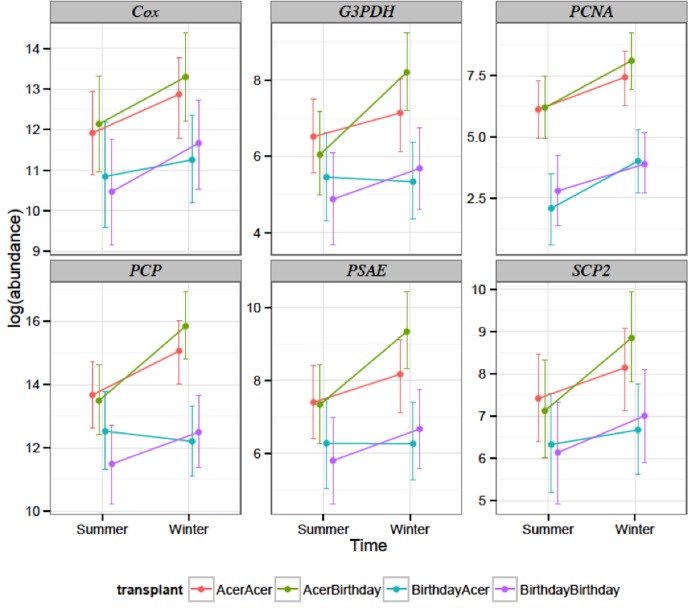
By-gene plot of transcript abundance for zooxanthellae genes obtained from sub-samples of Porites astreoides taken from Birthday reef and Acer24 reef during winter and summer sampling efforts.“AcerAcer” represents non-transplanted sub-samples that originated at Acer24 reef, whereas “AcerBirthday” represents transplanted sub-samples that were collected at Acer24 reef and transplanted to Birthday reef. “BirthdayBirthday” represents non-transplanted sub-samples that originated at Birthday reef, whereas “BirthdayAcer” represents transplanted sub-samples that were collected at Birthday reef and transplanted to Acer24 reef. Sub-samples collected in summer months are represented in orange, while sub-samples collected in winter months are represented in blue. Whiskers denote 95% credible intervals.